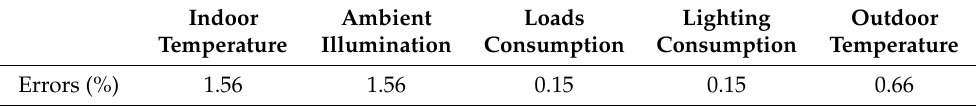
Table 1. Percentage of errors in the collection period of the variables considered.